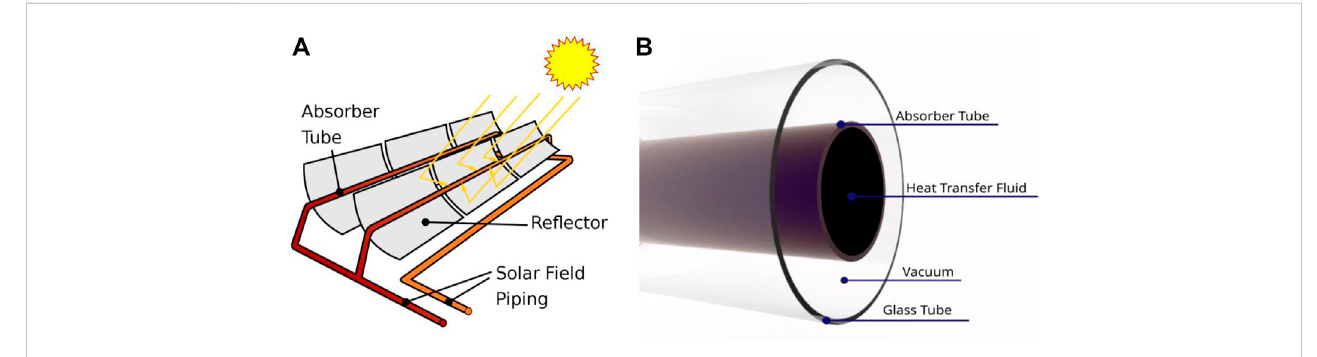
FIGURE 1 (A) Parabolic trough collector (PTC). (B) Cross-sectional diagram of the parabolic trough receiver (PTR) (Wang et al., 2015).